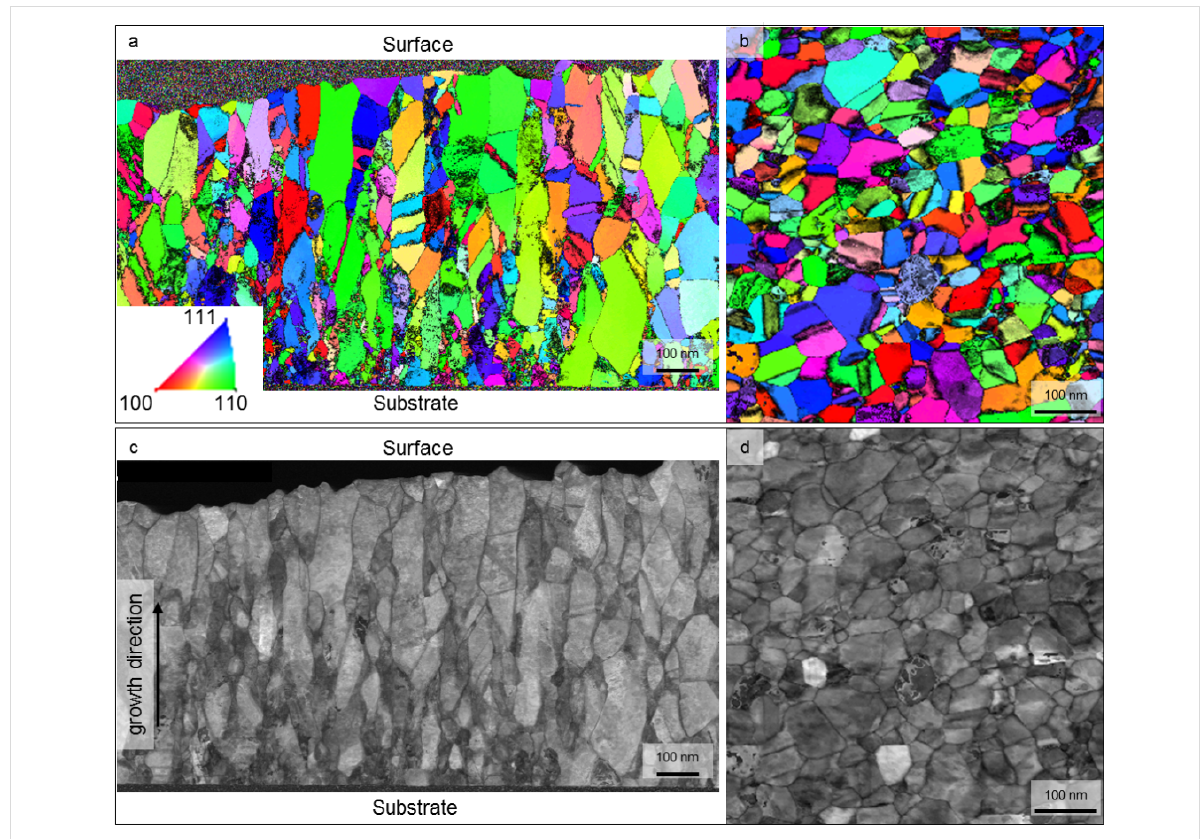
Figure 2: Orientation maps overlaid with reliability derived from ACOM-TEM of the as deposited sample in a) cross section and b) plane view (insets shows the color code for the orientation maps), c) and d) are the corresponding ACOM-TEM cross correlation index maps of the cross section and plane view, respectively.